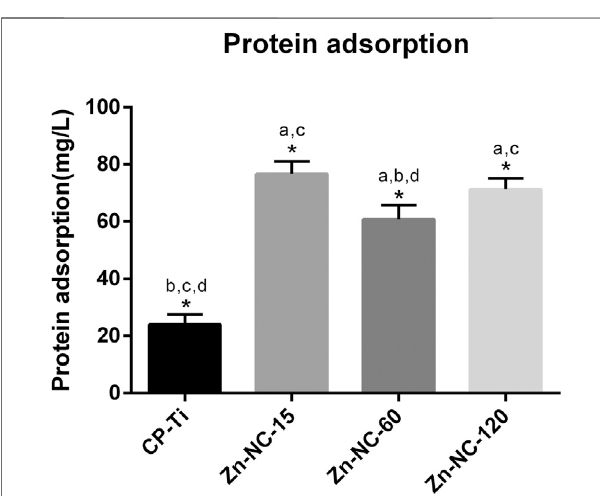
FIGURE 4 | Concentration of zinc ion released from Zn-NC-Ti surfaces into PBS after 10 min, 1 h, 4 h, 1, 4, and 7 days (n (cid:2) 3).